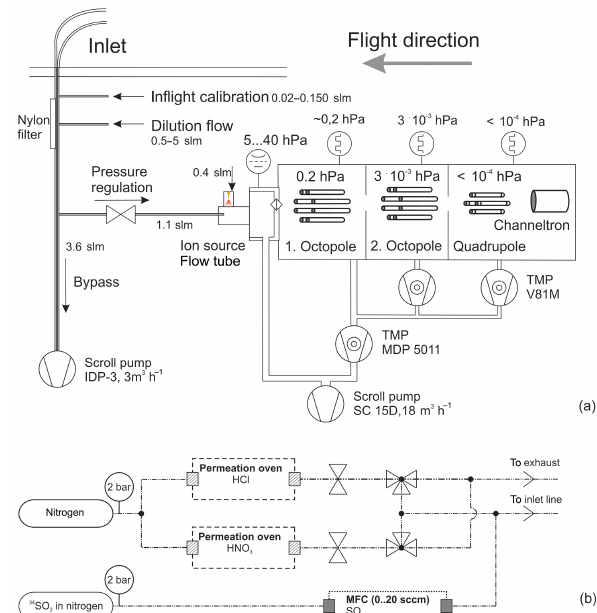
Figure 1. (a) Schematic of the flight configuration of AIMS-TG. Ambient air enters via two backward-facing inlets and passes a pressure regulation valve before entering the flow tube. One inlet line is equipped with a nylon filter for background measurements. The detailed setup of the ion source for the AIMS-TG measurement mode is depicted in Fig. 2. The ion beam of reagent and product ion is then focussed by two adjacent octopoles and finally separated by mass-to-charge ratio in the quadrupole. Connections for an optional dilution of ambient air and for addition of trace gases for in-flight calibration are mounted right beneath the inlet and are shown in detail in (b) . Two permeation ovens with PFA and glass containers are used for HCl and HNO 3 generation. Critical orifices regulate the flow that is either introduced in the upper inlet line or diverted to the exhaust. SO 2 is taken from a stainless steel cylinder filled with generally 2.7ppmv SO 2 in N 2